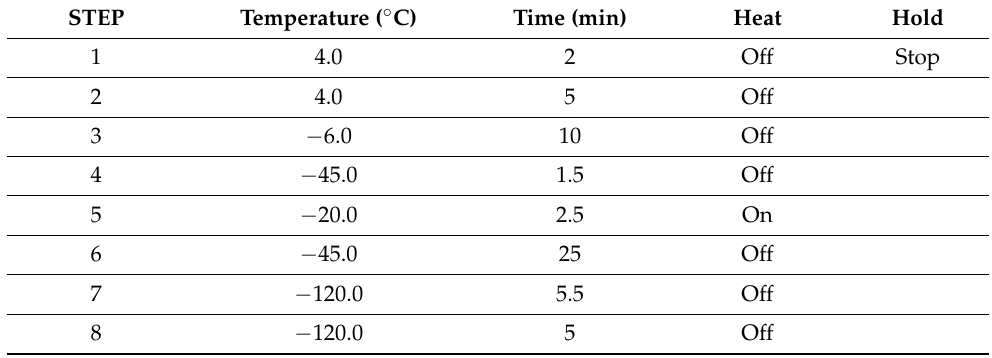
Table 2. PBMC freezing program of the controlled rate biofreezer IceCube 14